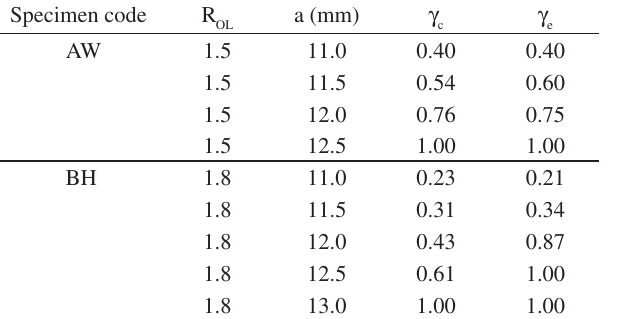
Table 6. Experimental and Willenborg -predicted values of the retardation factor at different crack length increments within the delay zone. Specimen code